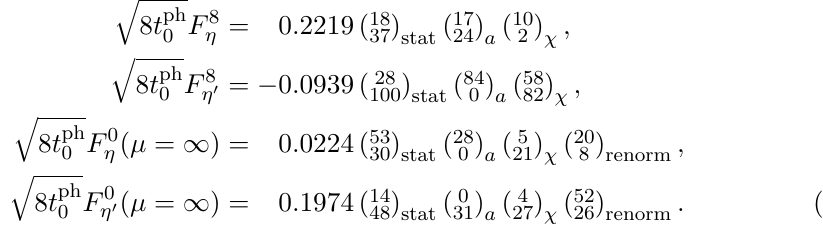
procedure described in the previous subsection. Our best fit gives χ 2 /N df ≈ 91 / 41 ≈ 2 . 35 and includes the two quark mass dependent discretization terms n M fit is displayed in figure 17 in appendix C. The masses extracted at the physical